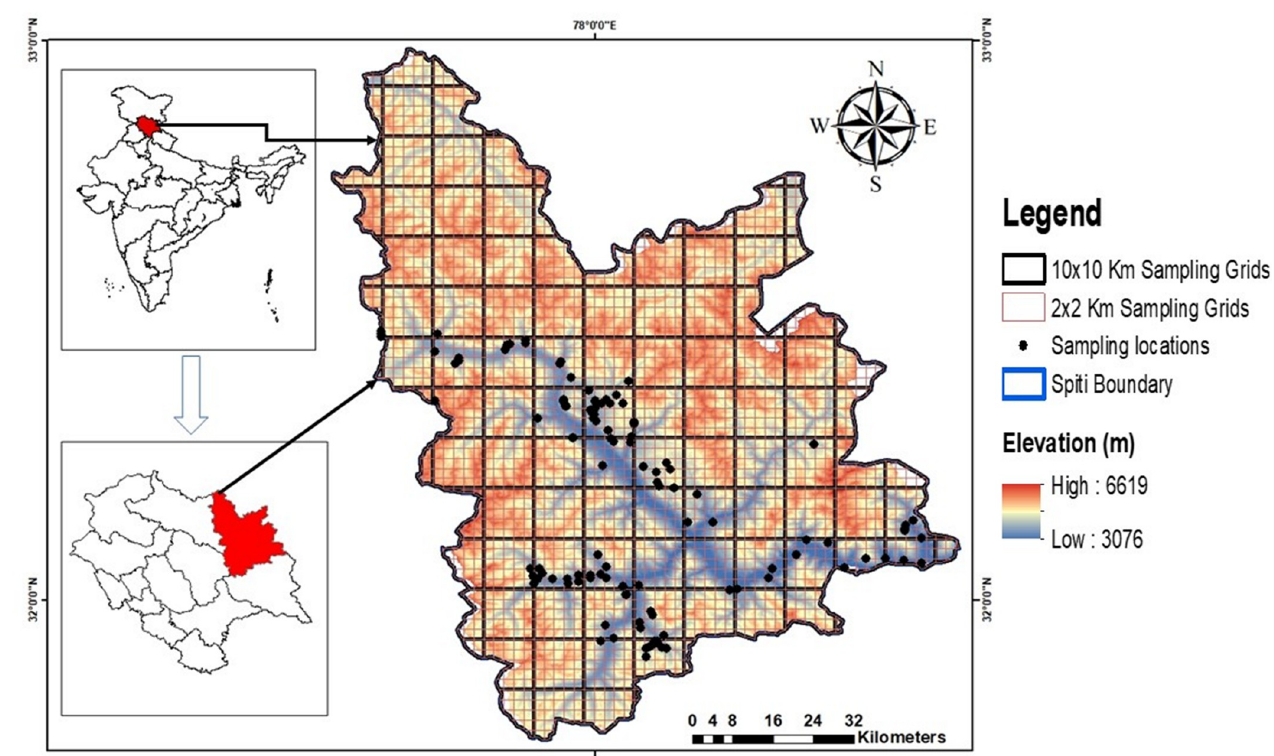
Fig 1. Map of study area Spiti Valley, Himachal